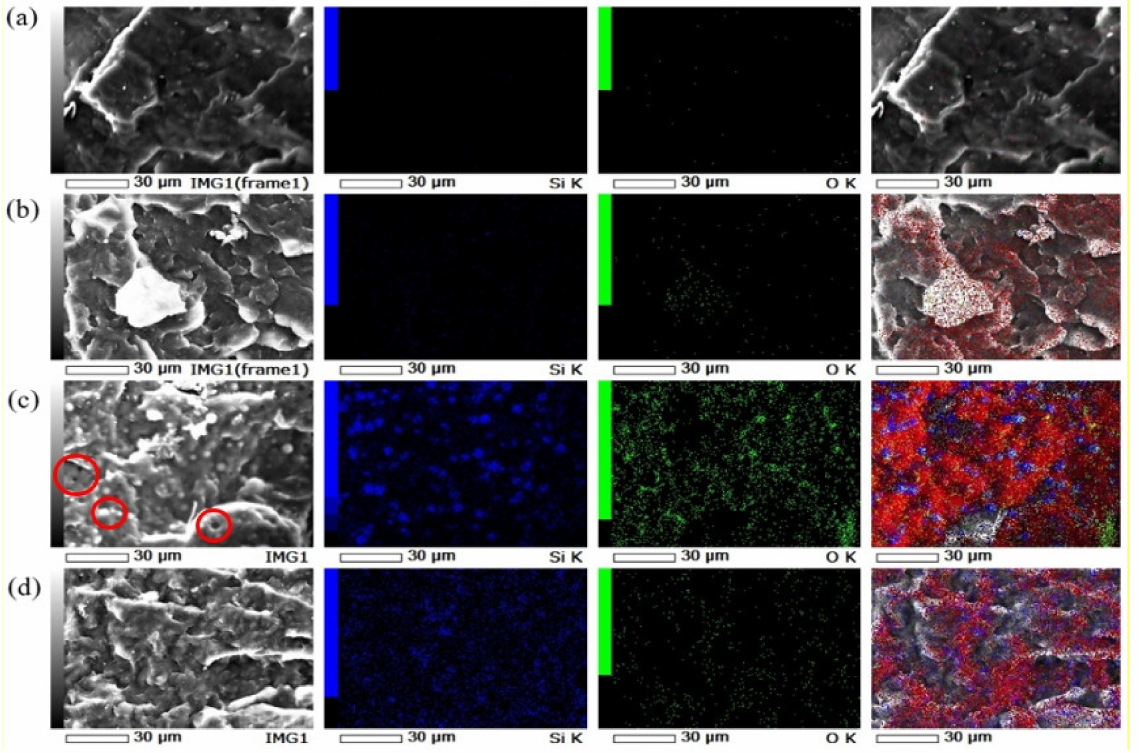
Figure 9. SEM images mapped with EDS analysis for distribution of oxygen (O) element represents CNF and silica (Si) element represent SiP: ( a ) PP polymer, ( b ) PP-1.25 CNF, ( c ) PP SS/CNF and ( d ) PP